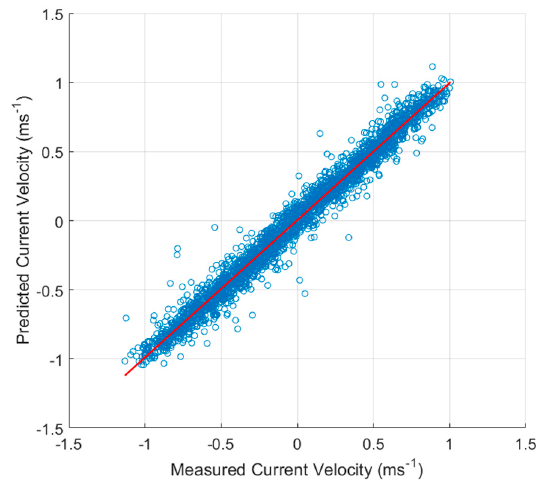
Figure 2. Scatterplot of the measured vs. predicted east velocities at 20 m above the seabed by BR, around the exact fit line.